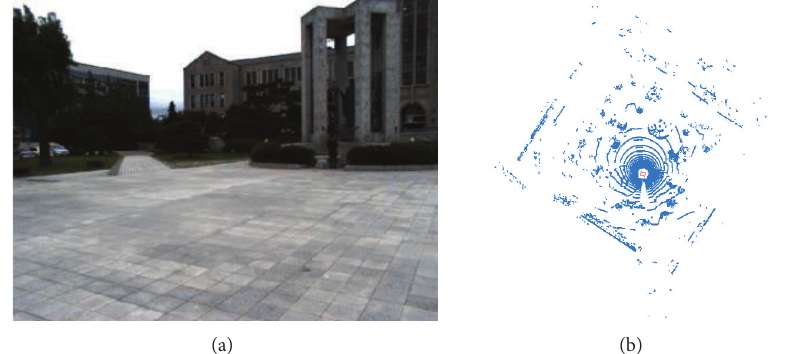
Figure 8: Datasets received from multiple sensors. (a) A captured 2D image. (b) 180 packets of point cloud received from